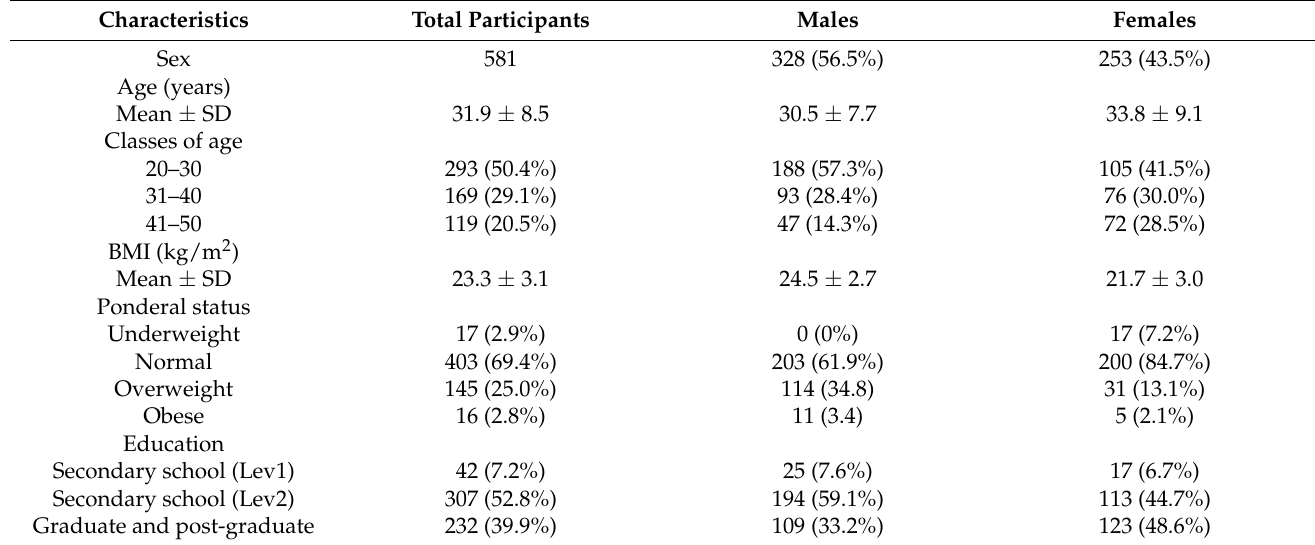
Table 1. Participant characteristics (mean, standard deviation, numbers, percentages).